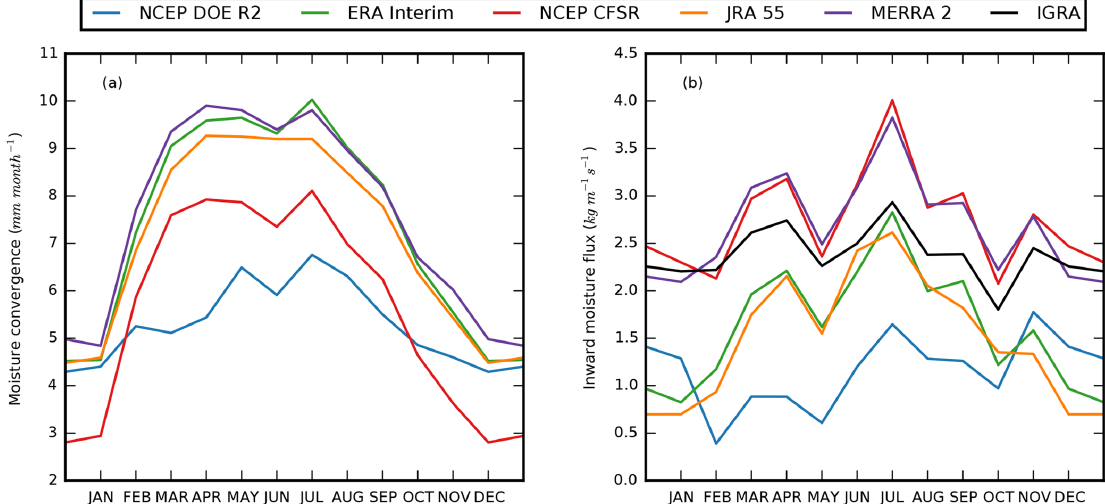
Figure 6. Annual cycle of moisture transport into East Antarctica (a) computed from reanalyses averaged over East Antarctica, (b) observa- tions and reanalyses (with the same spatial and temporal sampling) averaged over all stations.